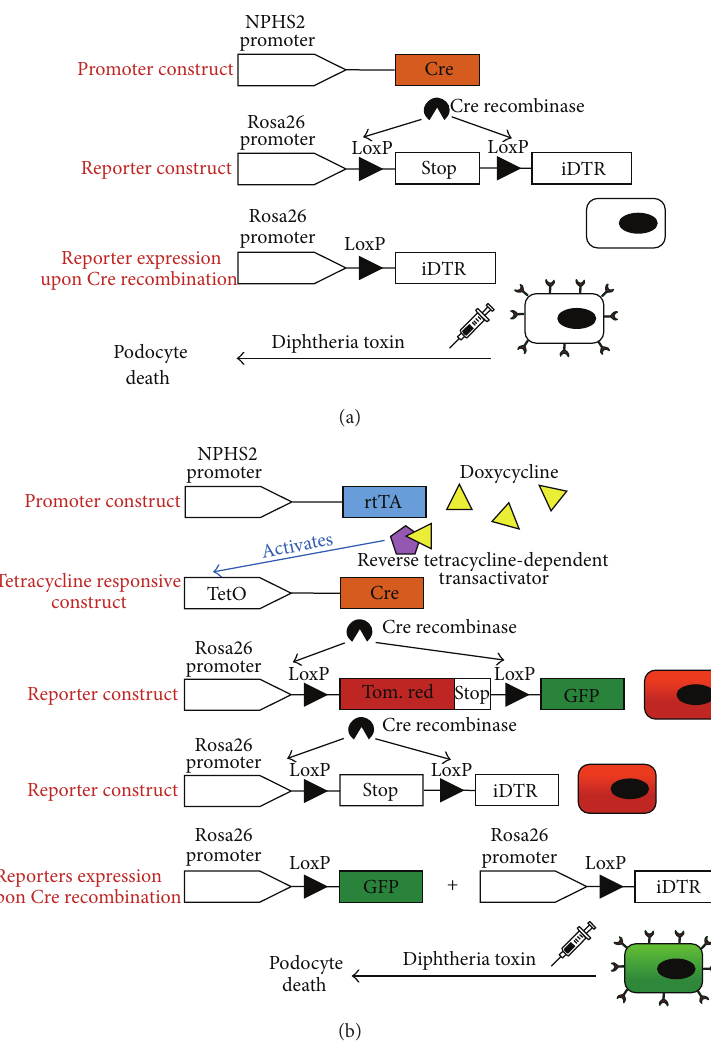
Figure 3: DTR models and strategies. (a) Schematic representation of a floxed Stop cassette followed by DTR transgene targeted under the Rosa26 promoter. The reporter transgene, activated upon Cre recombinase activity induced by podocin promoter activation, forces podocytes to express the DT receptor. The operator can thus easily induce podocyte cell death in a time- and dose-controlled manner. (b) Quadruple transgenic hNPHS2.rtTa; TetO.Cre; mT / mG ; iDTR, in which podocytes can be prompted to turn from red to green while expressing the DTR. Once induced, the authors provoked podocyte death through DT injection